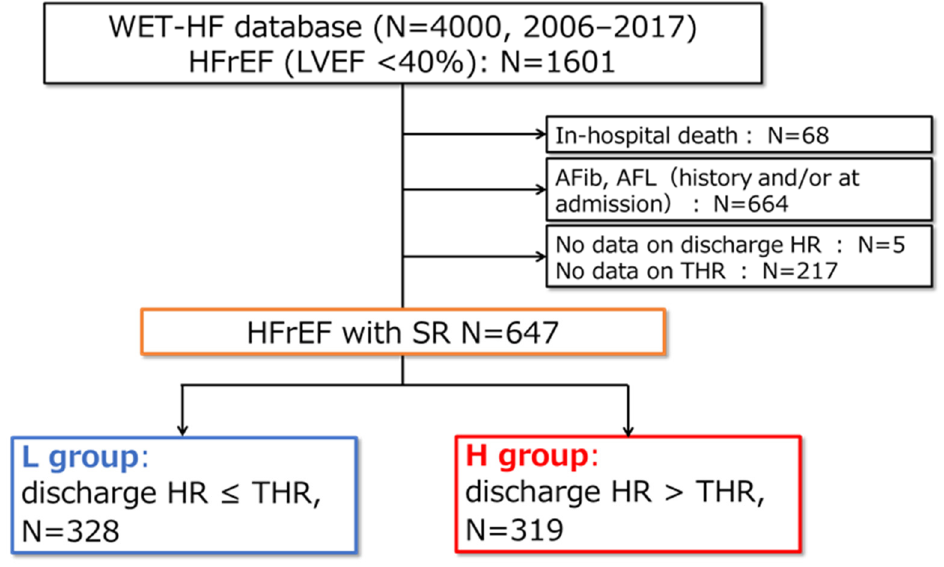
Figure 1. Flowchart of the study. The L group was defined as the patients whose discharge HR was less than or equal to the THR calculated by the following formula (THR [bpm] = 93 − 0.13 × Dct [ms]), and H group was defined as those whose discharge HR is higher than the THR. WET-HF: West Tokyo Heart Failure, HFrEF: heart failure with reduced ejection fraction, AFib: atrial fibrillation, AFL: atrial flutter, discharge HR: heart rate at discharge, THR: target heart rate, SR: sinus rhythm.